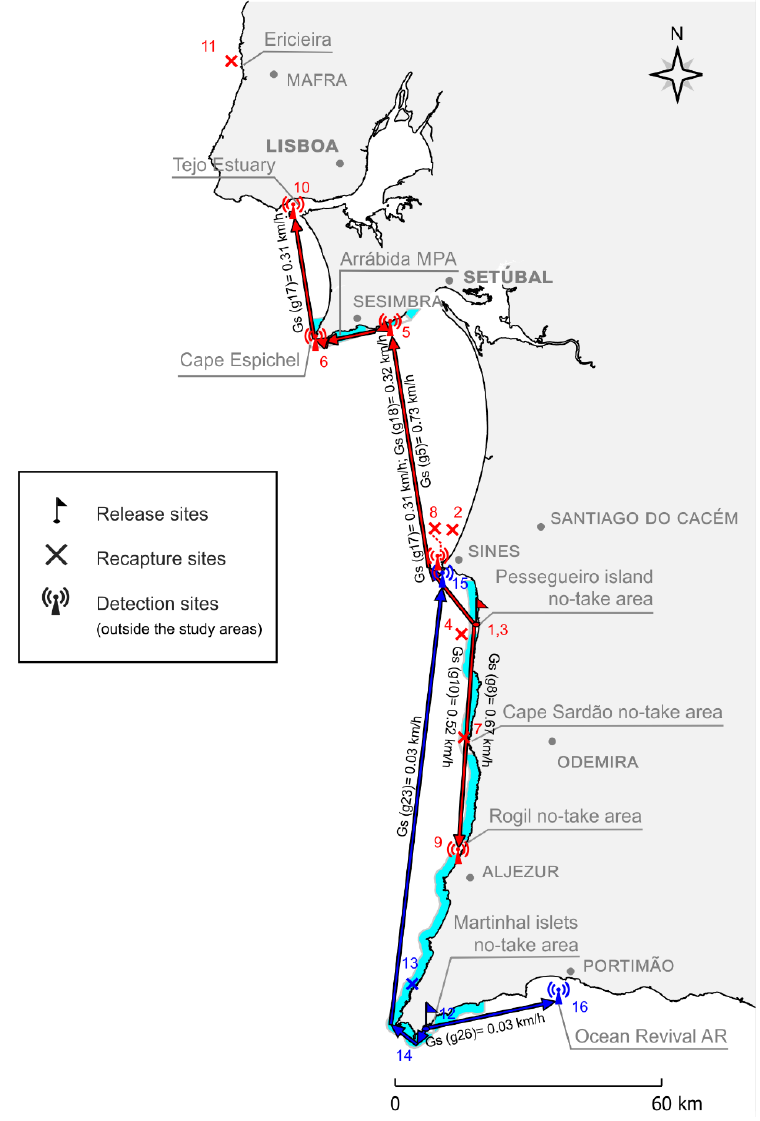
Figure 7. Locations of dusky groupers detections in other biotelemetry acoustic receivers’ arrays, by manual tracking surveys and recaptures by professional or recreational fishers, after leaving the no-take areas. Numbers are not necessarily by timeline order of records but by the order in which they are indicated in Table 6. Some of the movements are represented by arrows with the respective ground speeds (Gs) and groupers (g#). Red and blue arrows correspond to long-distance ranging movements performed by dusky groupers released in the Pessegueiro island no-take area and Martinhal islets no-take area, respectively.